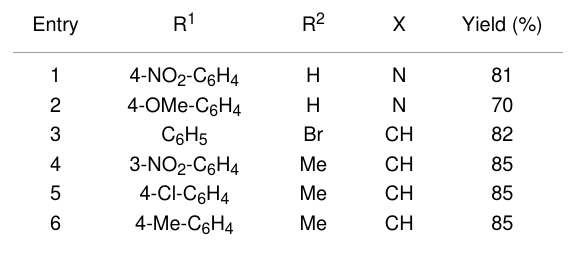
Table 11: Effect of substitutions in the synthesis of azines/diazines.